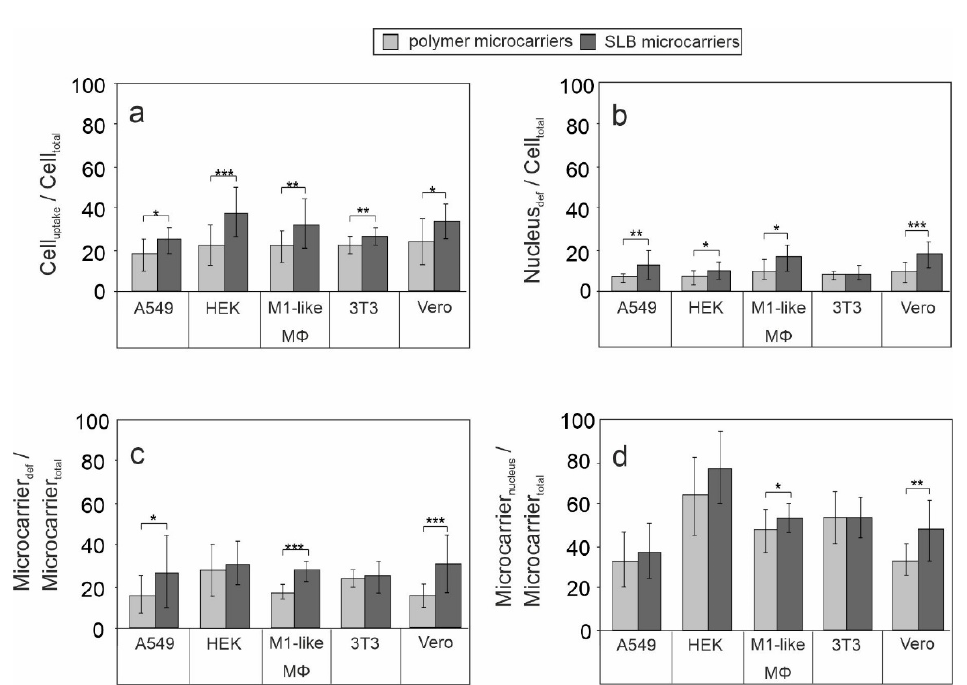
Figure 5. Determination of several parameters describing microcarrier interaction with cells. ( a ) shows internalized (Cell uptake ) and ( b ) microcarrier-induced nuclear deformation (Nucleus def ) to total cell number (Cell total ); ( c ) microcarriers involved in nuclear deformation (Microcarrier def ) and ( d ) nucleus-near, non-deforming microcarriers (Microcarrier nucleus ) to total intracellular microcarrier number (Microcarrier total ), ( n = 3, five random microscopic fields were used for quantification t -test, * p < 0.05, ** p < 0.01, *** p < 0.001).